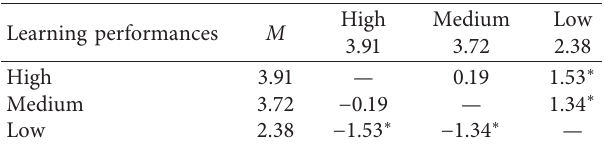
Table 11: Pairwise comparisons of creativity in programming among different learning